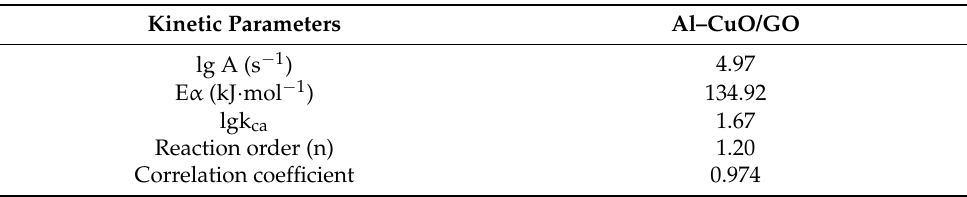
Figure 17. DSC curves of Al–CuO/GO at four heating rates compared between experiments and simulations. Table 5. The optimal values of the kinetic factors of Al–CuO/GO obtained using the nonlinear multivariate regression